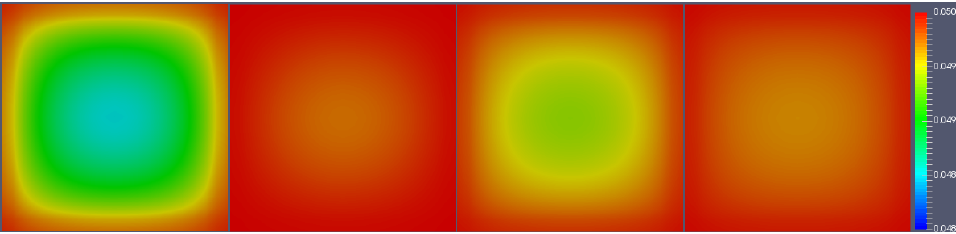
Figure 4. Oxygen distribution patterns over grain for 8 min, 16 min, 24 min and 32 min.